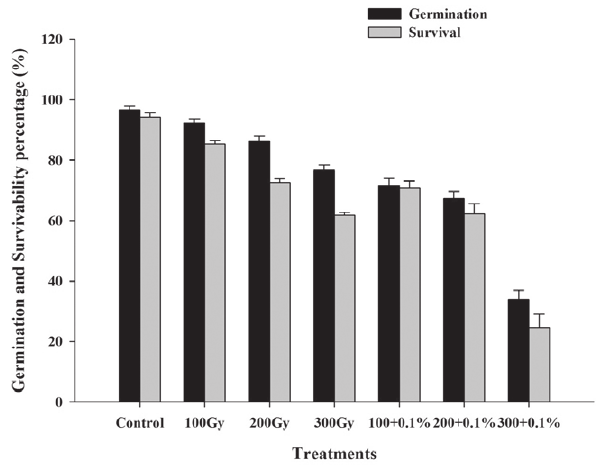
Figure 1. Effect of Gamma ray and Combination treatment on ger- mination and survival in Artemisia annua L. (M1 generation).